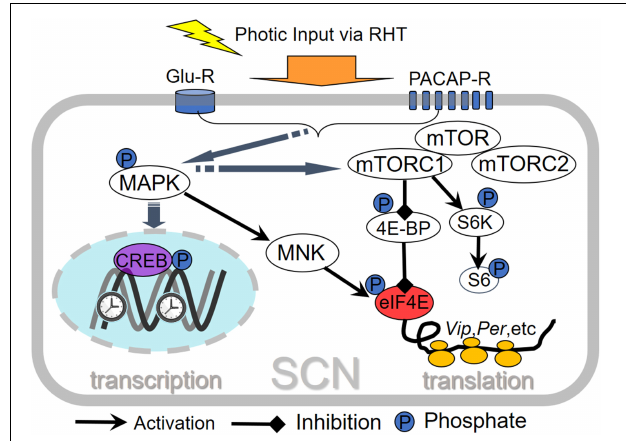
FIGURE 1 | Schematic overview of light-regulated translational control pathways in the SCN. Light at night activates mTORC1, which in turn regulates its translational effectors ribosomal protein S6 kinases (S6Ks, including S6K1, and S6K2) and eukaryotic translation initiation factor 4E-binding proteins (4E-BPs). 4E-BP phosphorylation leads to its dissociation from eIF4E and activation of cap-dependent translational initiation. Vip (vasoactive intestinal peptide) mRNA translation is regulated by 4E-BPs. In another pathway, photic ERK/MAPK activation leads to phosphorylation of eIF4E via MNK kinases and promotes mRNA translation of Per1 and Per2 in the SCN. Thus, the MAPK and mTOR pathways converge on eIF4E to regulate mRNA translation in the